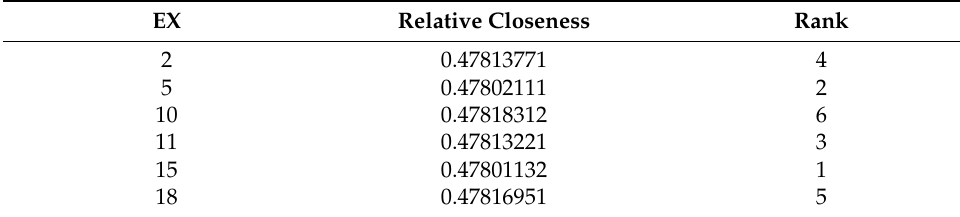
Table 12. Relative closeness.